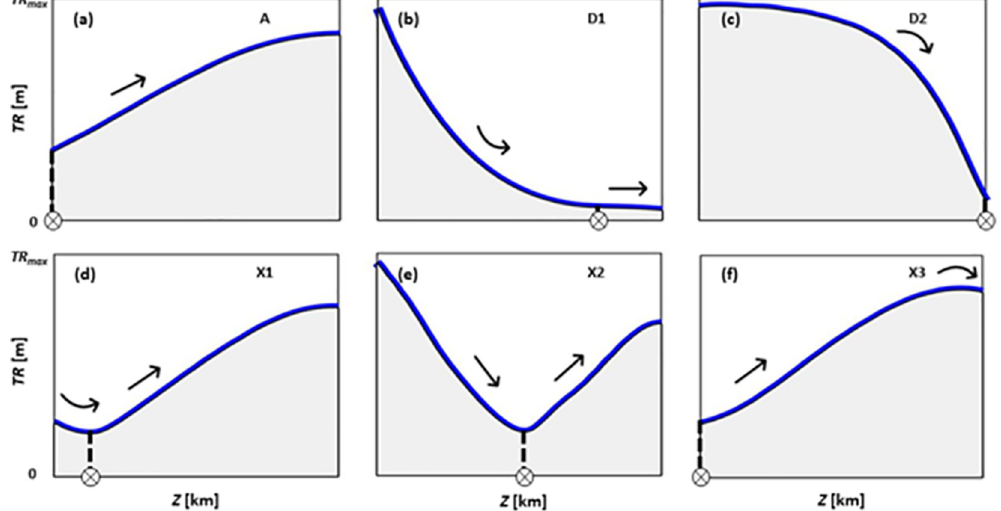
Fig 2. Conceptual (general) patterns of tidal range TR including (a) amplification (pattern A); (b) dampening with a concave-shaped decline (pattern D1); (c) dampening with a convex-shaped decline (pattern D2); (d) a mixed pattern (pattern X1) where TR decreases to the minimum before it rises to an upstream value higher than at the mouth; (e) a mixed pattern (pattern X2) where TR decreases up to the minimum and then starts rising with the upstream TR less than at the mouth; and (f) a mixed pattern (pattern X3) where TR increases to a maximum and then decreases. Circled crosses show the location of the minimum TR and arrows illustrate the direction of change in TR